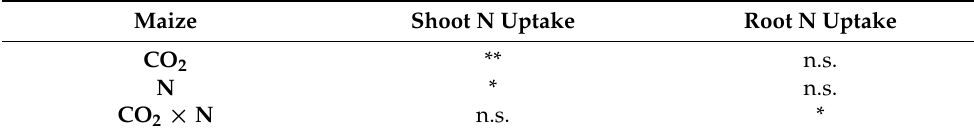
Table 11. Two-factor ANOVA analyses for N uptake in maize seedlings. Maize Shoot N